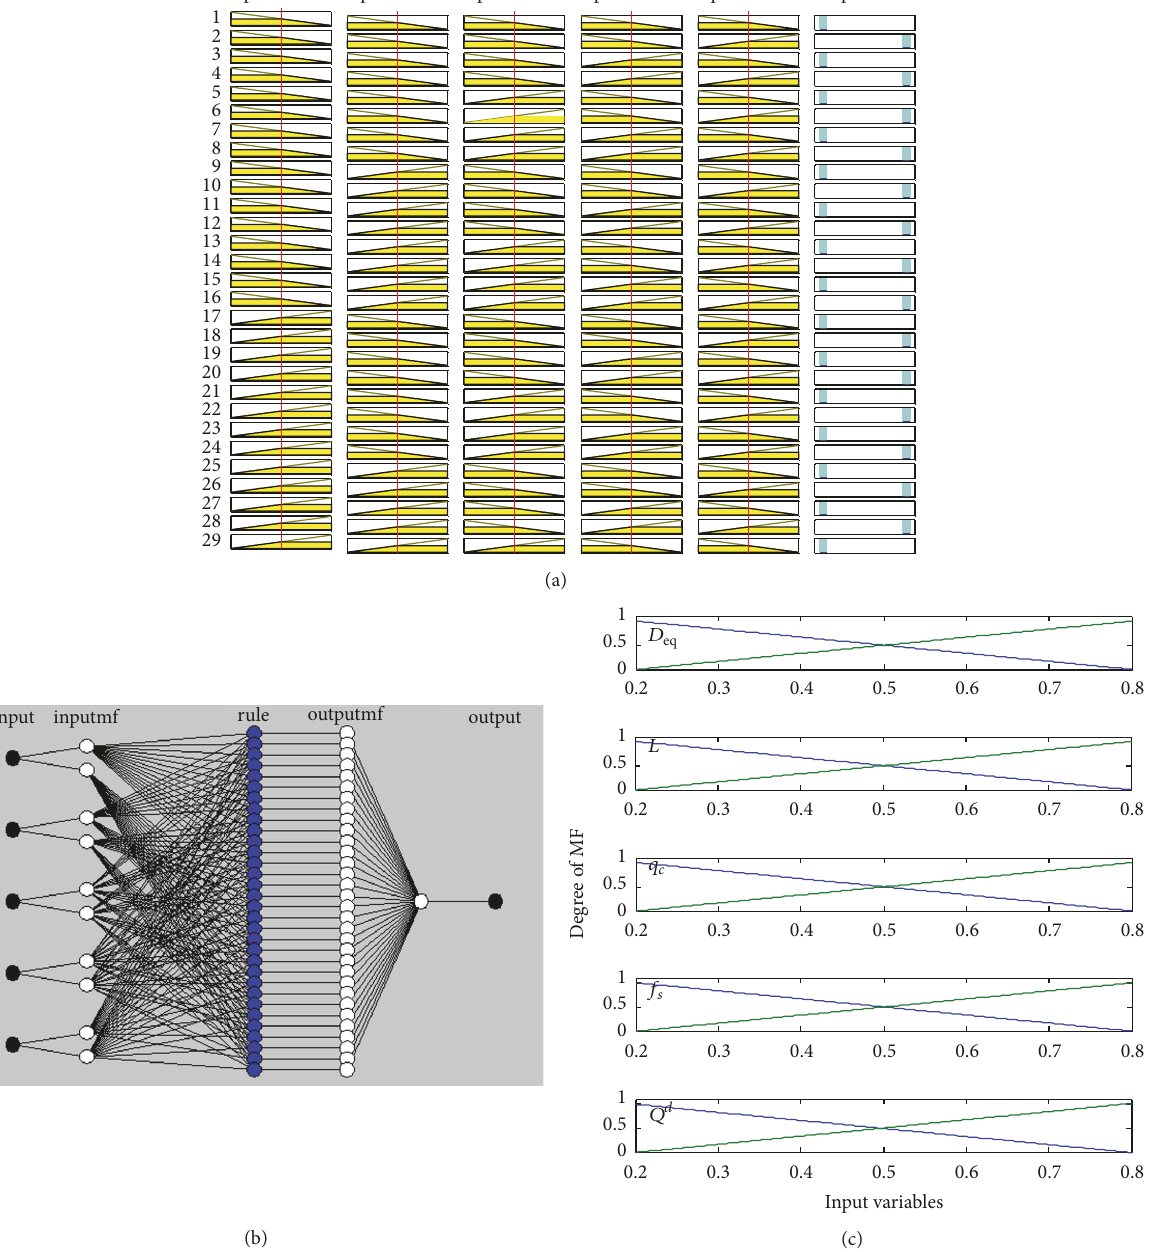
Figure 5: DANFIS model design: (a) model application, (b) typical model architecture with five inputs, and (c) adjusted MF for the five inputs variables.